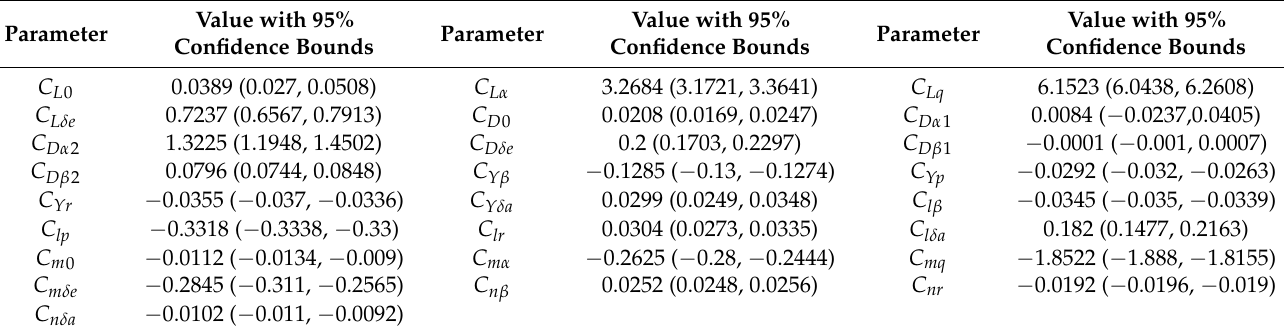
Table 2. Aerodynamic coefficients of the